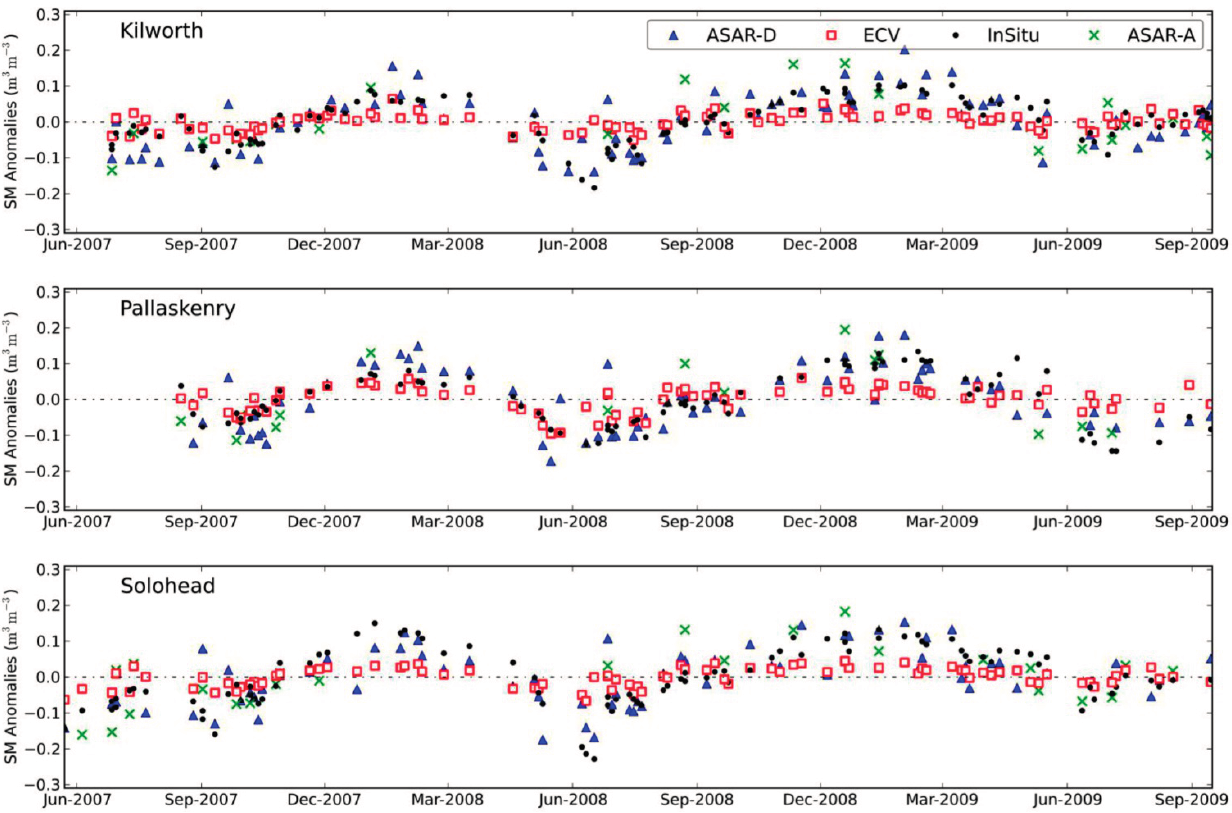
Figure 3. Temporal evolution of ASAR, ECV and in situ SM anomalies estimated in the 2007–2009 time